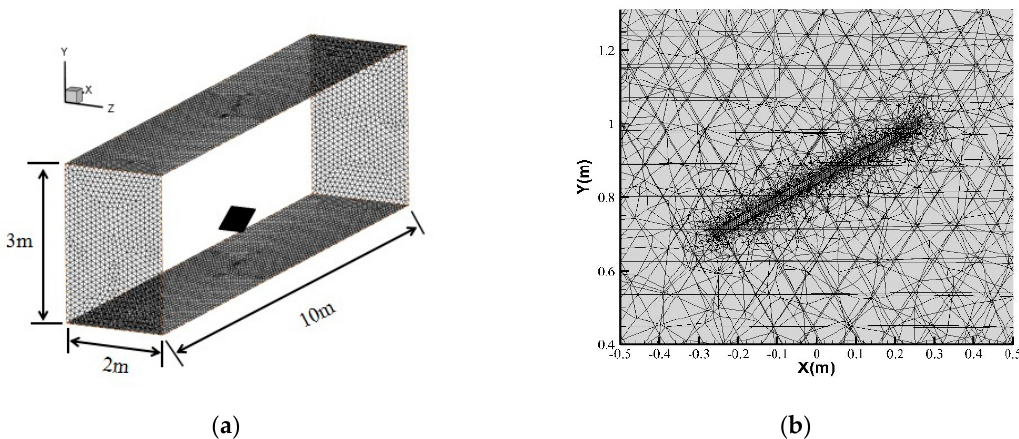
Figure 2. Sketch of the numerical model’s geometry. ( a )The simulation zone. ( b ) Modeling grids.